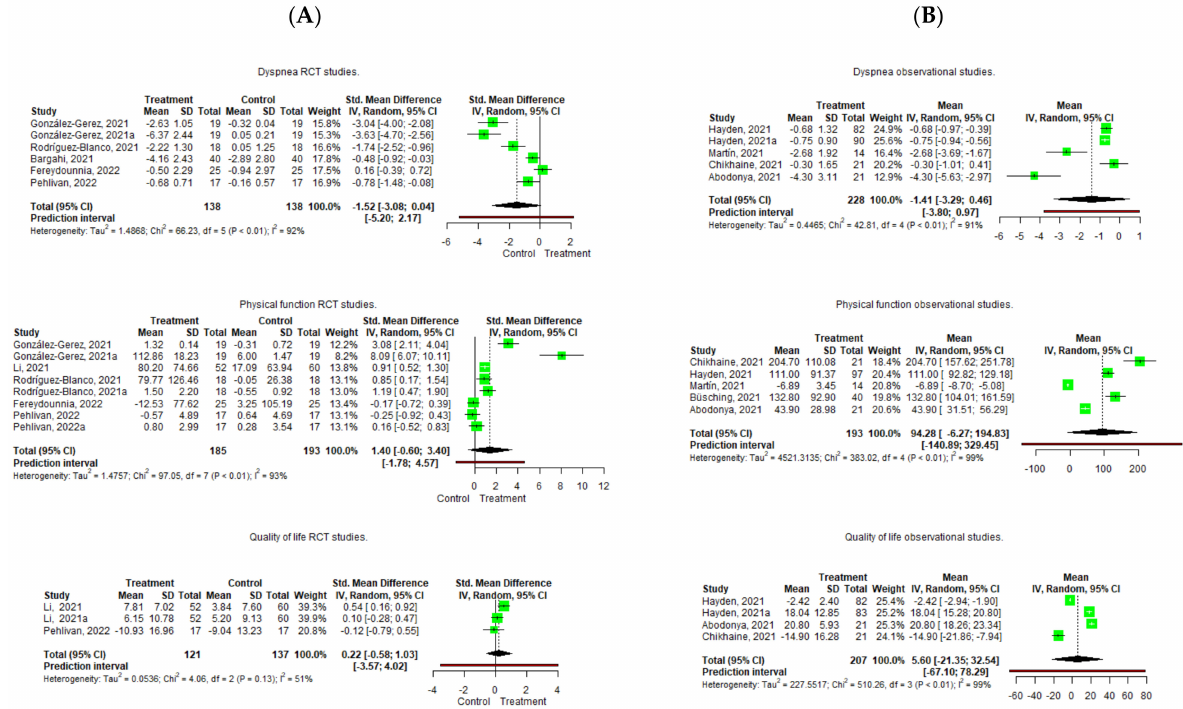
Figure 3. Forest plot of the effect of Pulmonary Rehabilitation in post-acute patients with COVID-19 related to physical function, dyspnea, and quality of life. ( A ) RCTs assessed; ( B ) Observational studies assessed. Pooling of the five included RCTs [49,51–54] did not result in significant effects on dyspnea improvement, with a lower pre-postintervention change in the treatment group (Hedge’s g = − 1.517 95%, CI − 3.076; 0.041, Z = − 2.502, p = 0.054) and with an